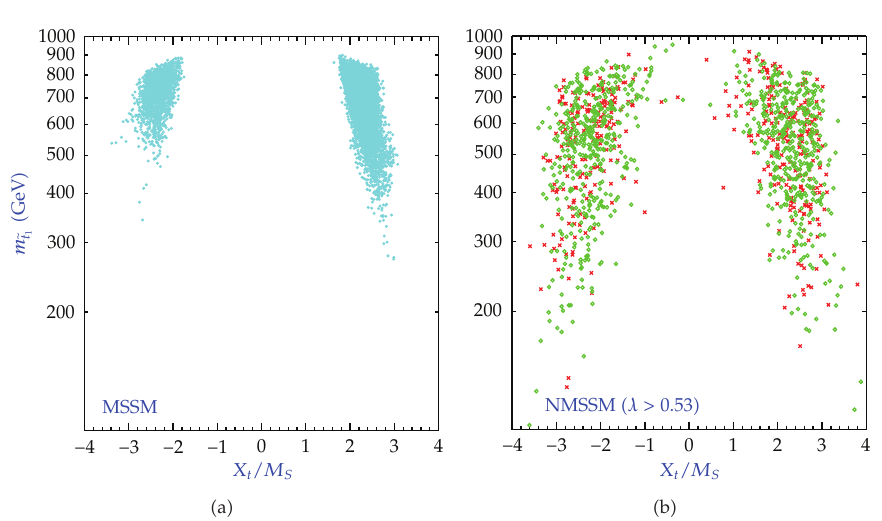
(cid:11) m (cid:4) m (cid:4) and X t ≡ A t − μ cot β . In the right panel t 1 t 2